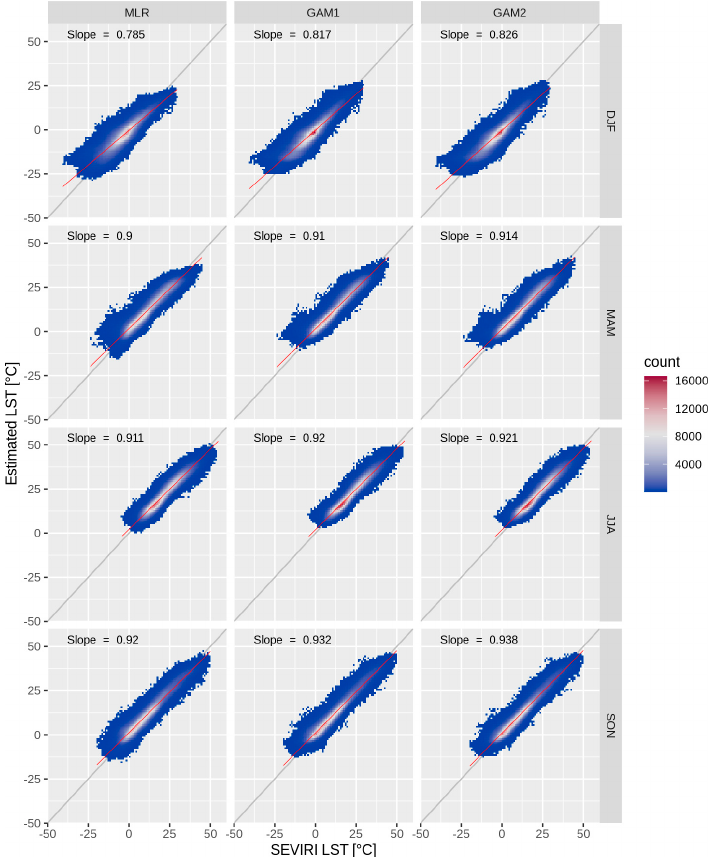
Figure 5. Seasonal scatterplots: hourly raw SEVIRI LST data vs. hourly estimated SEVIRI LST (2016– 2017), based on randomly selected pixels (300/h). Red lines show the best fit lines of the linear model between the two analyzed datasets, and the grey lines are the perfect fit linear models. Considering that the GAM2 model provides the closest estimates of the measured data according to all the criteria used, it was decided that this method should be applied to supplement